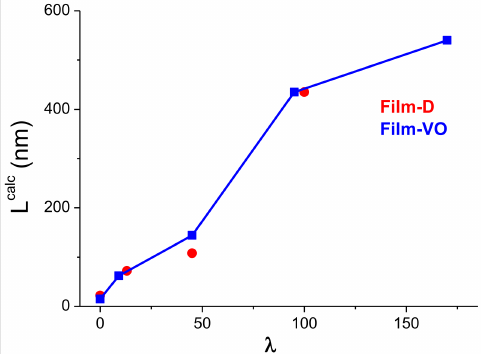
Figure 11. Dependence of the parameter L calc on the draw ratio of the films from xerogel-D and